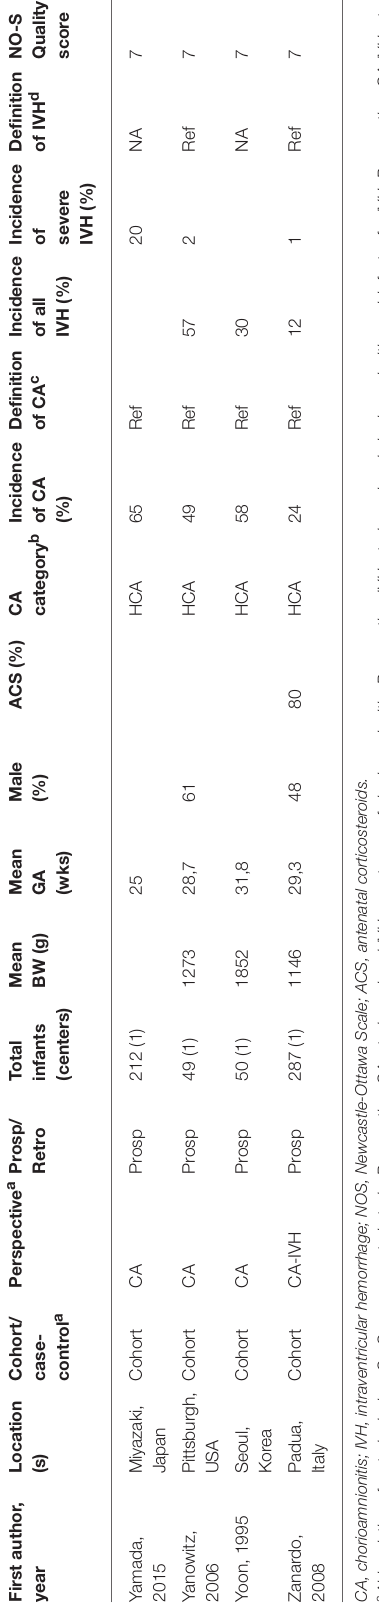
Supplementary Table 2 | Newcastle-Ottawa Quality assessment of included